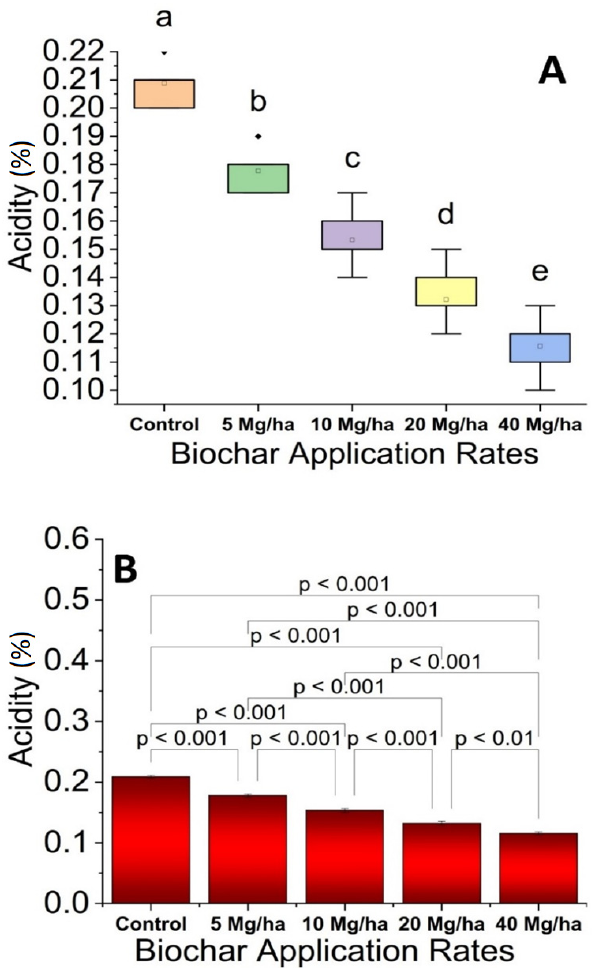
Figure 6. Effect of different biochar application rates on mango fruit juice acidity. Bars are mean of 9 replicates. Different letters show a significant difference at p ≤ 0.05 ( A ). Probability value hierarchy for fruit juice acidity is provided in ( B ).